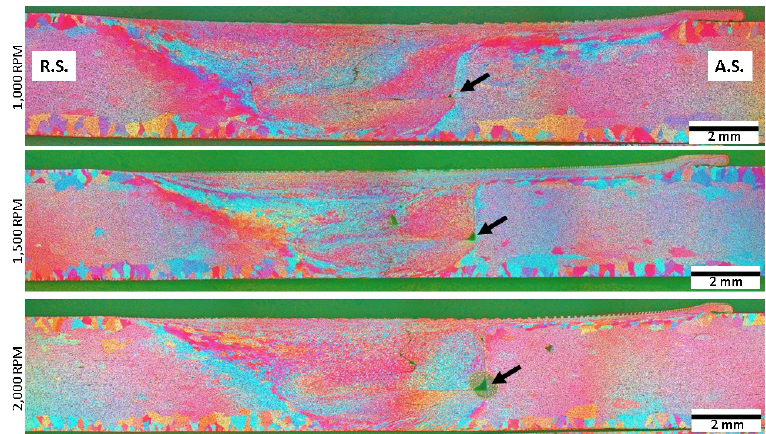
Figure 4. Optical macrograph results of the extruded samples AA6005-T6 after welding by FSW at different tool rotational